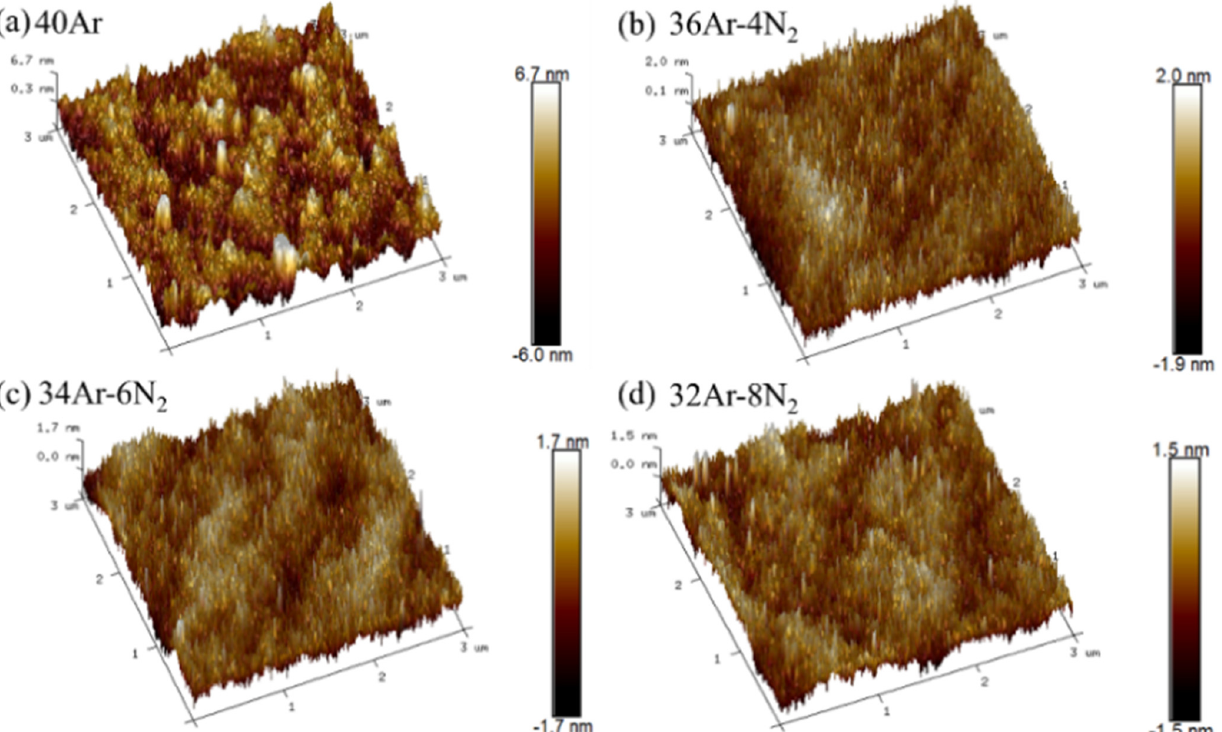
Figure 4. AFM images of Ta 2 O 5 coatings deposited at a sputtering power of 140 W under different N 2 and Ar flow rates. ( a ) 40Ar, ( b ) 36Ar4-N 2 , ( c ) 34Ar-6N 2 , ( d ) 32Ar-8N 2 .